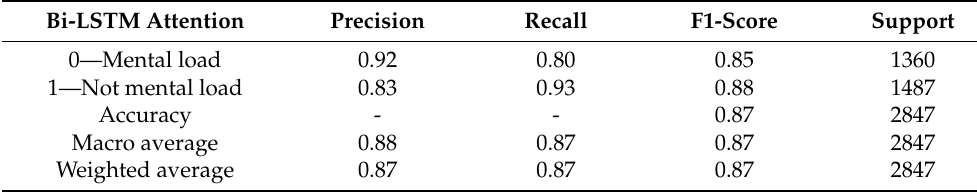
Table 5. Model performance of Bi-LSTM